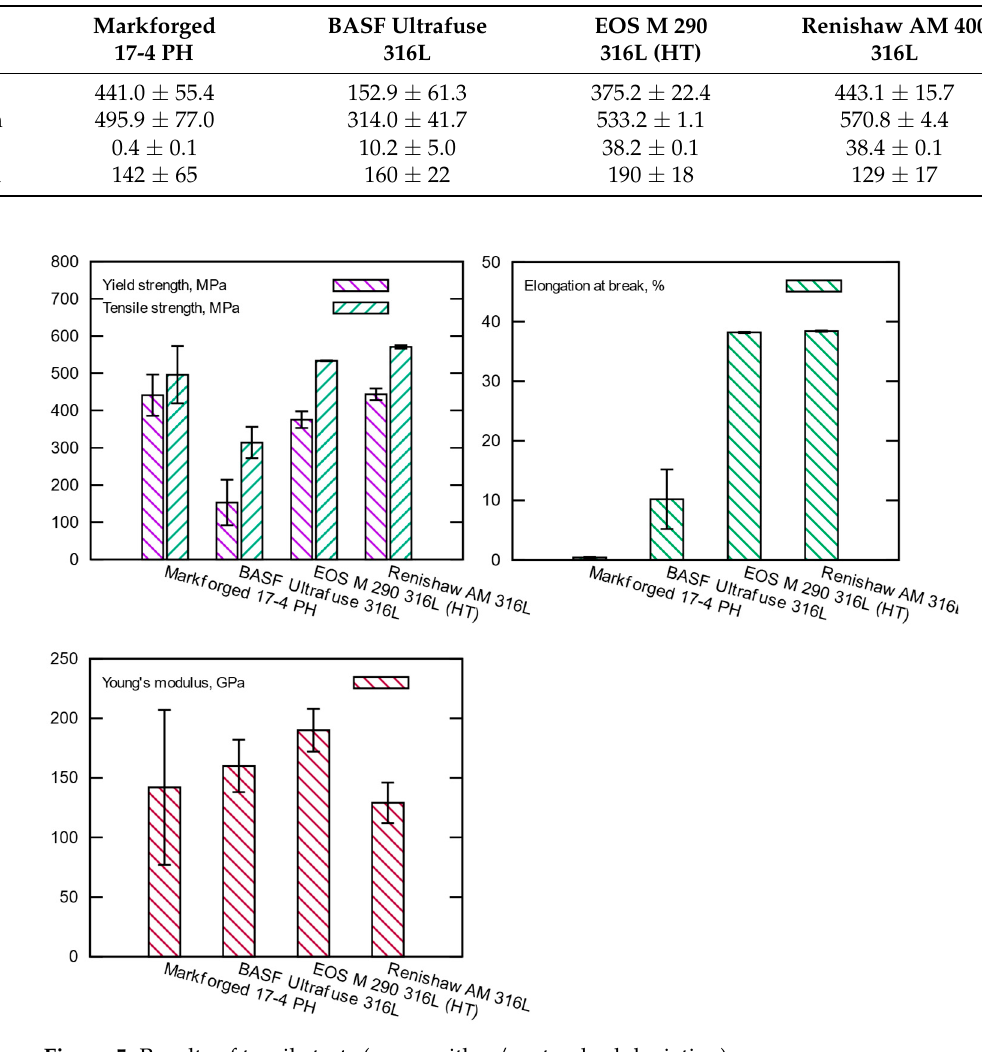
Table 6. Material properties as indicated by the manufacturer’s data sheets.